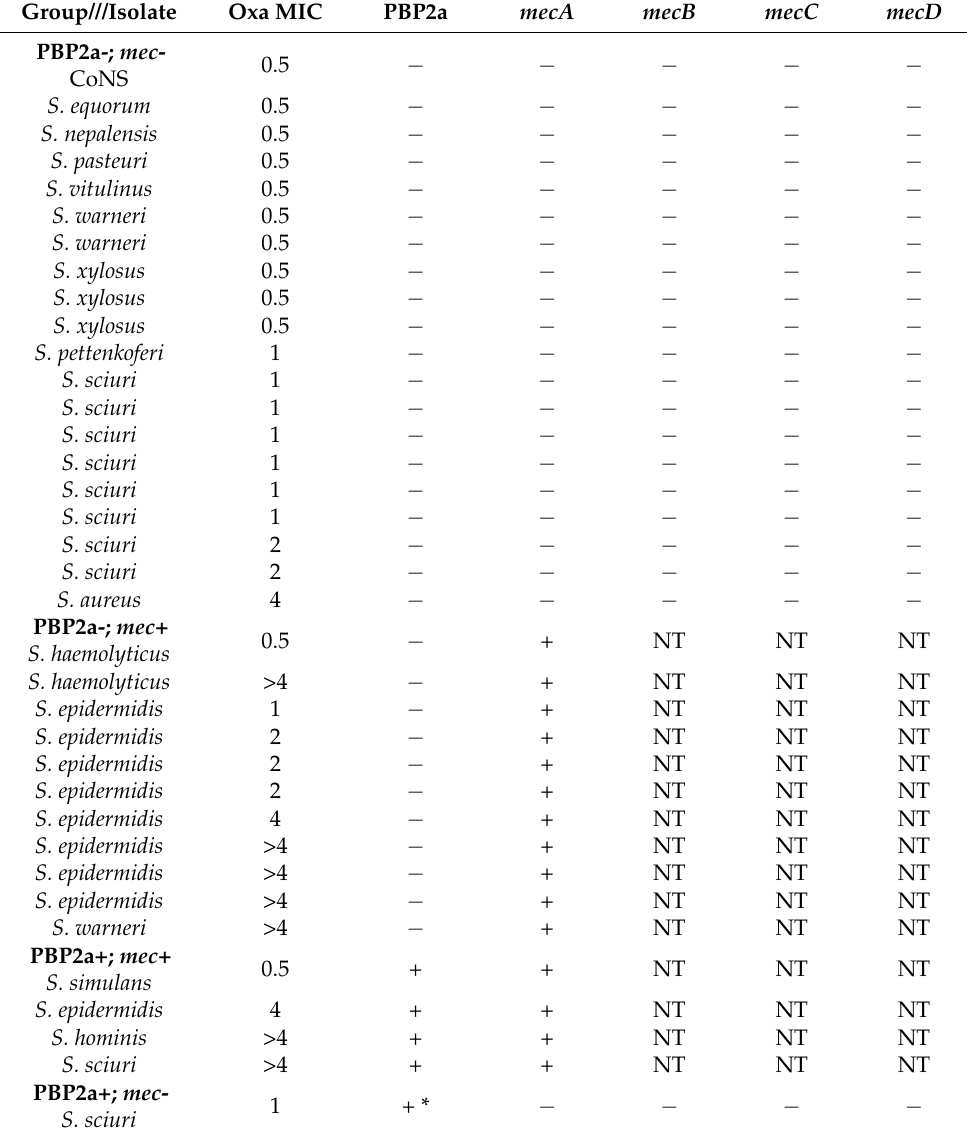
Table 4. Detection of PBP2a protein (by a latex agglutination test) after an additional 24 h incubation of cultures and mec genes (by PCR) in MRS isolates ( n = 36) that were initially tested as PBP2a negative following the standard (24 h) incubation